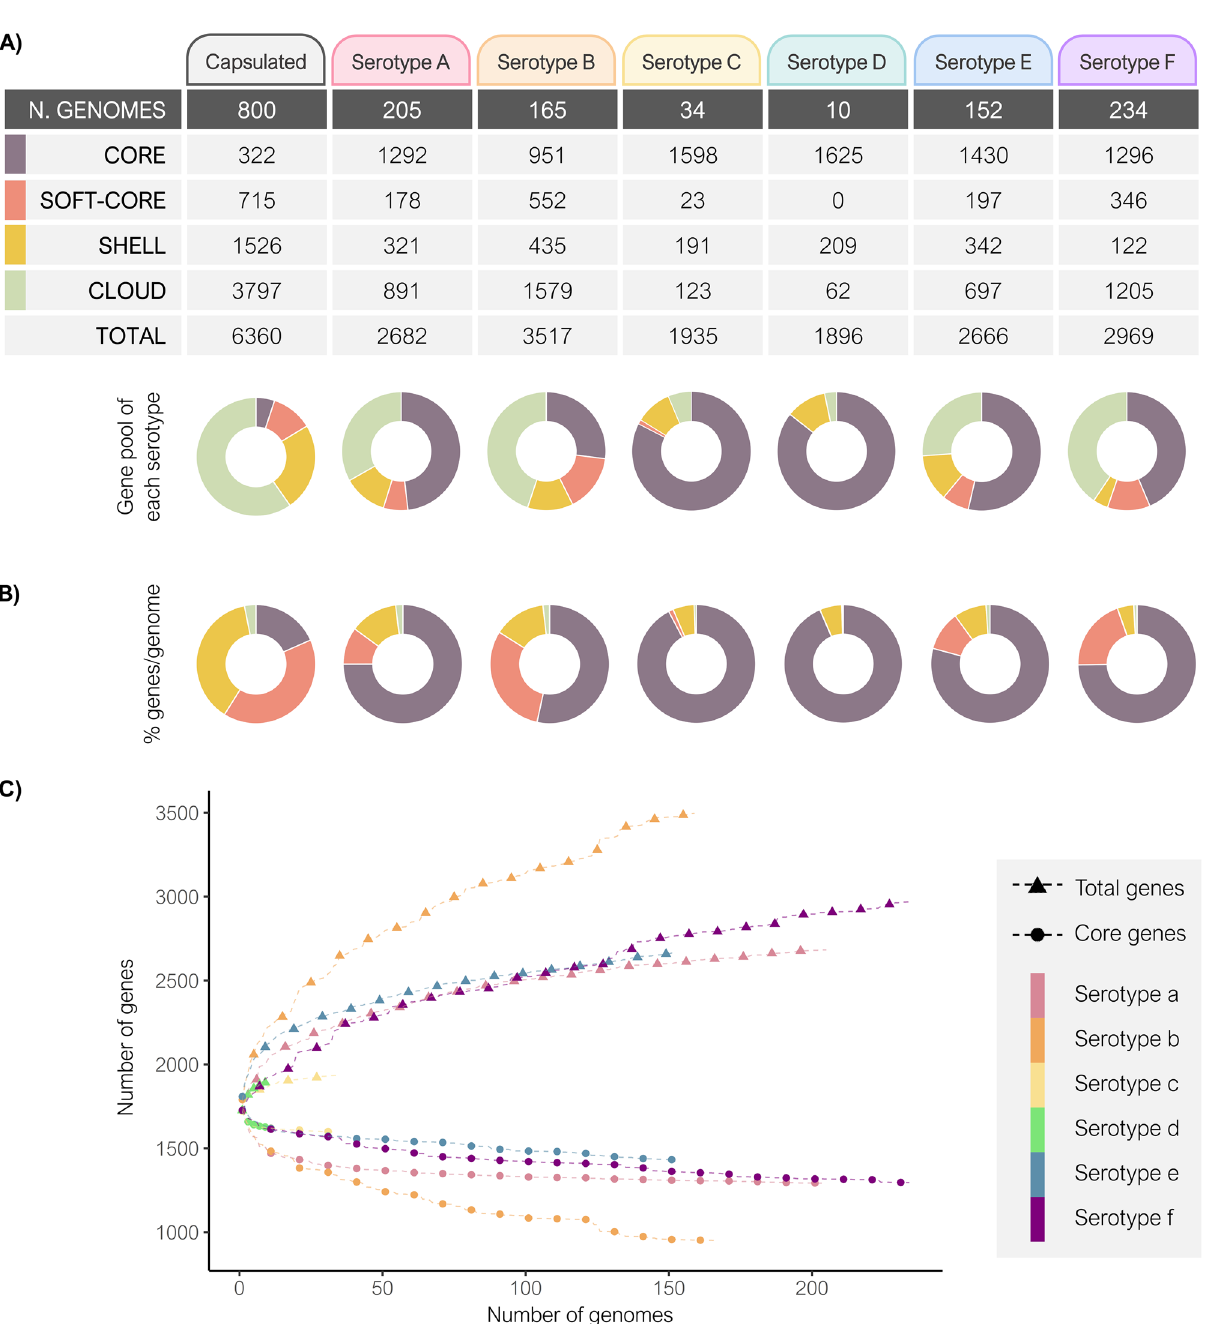
Figure 2. Pangenomic analysis of capsulated H. influenzae . ( A ) Gene pool of capsulated H. influenzae genomes included in this study. The number of core, soft-core, shell, cloud, and total genes of each serotype was determined using Roary, with a minimum identity percentage of 70% for BLASTp and the -cd parameter adjusted to 100. ( B ) Relative pangenome composition represented as a percentage of genes per genome of each serotype. Gene pool was defined as the set of all genes in a population. Donut charts indicate the distribution of core (100% of genomes), soft-core (95–99%), shell (15–94%), and cloud genes (< 15%). ( C ) Correlation between total and core genes in all capsulated H. influenzae genomes from this study and from the NCBI and ENA databases by